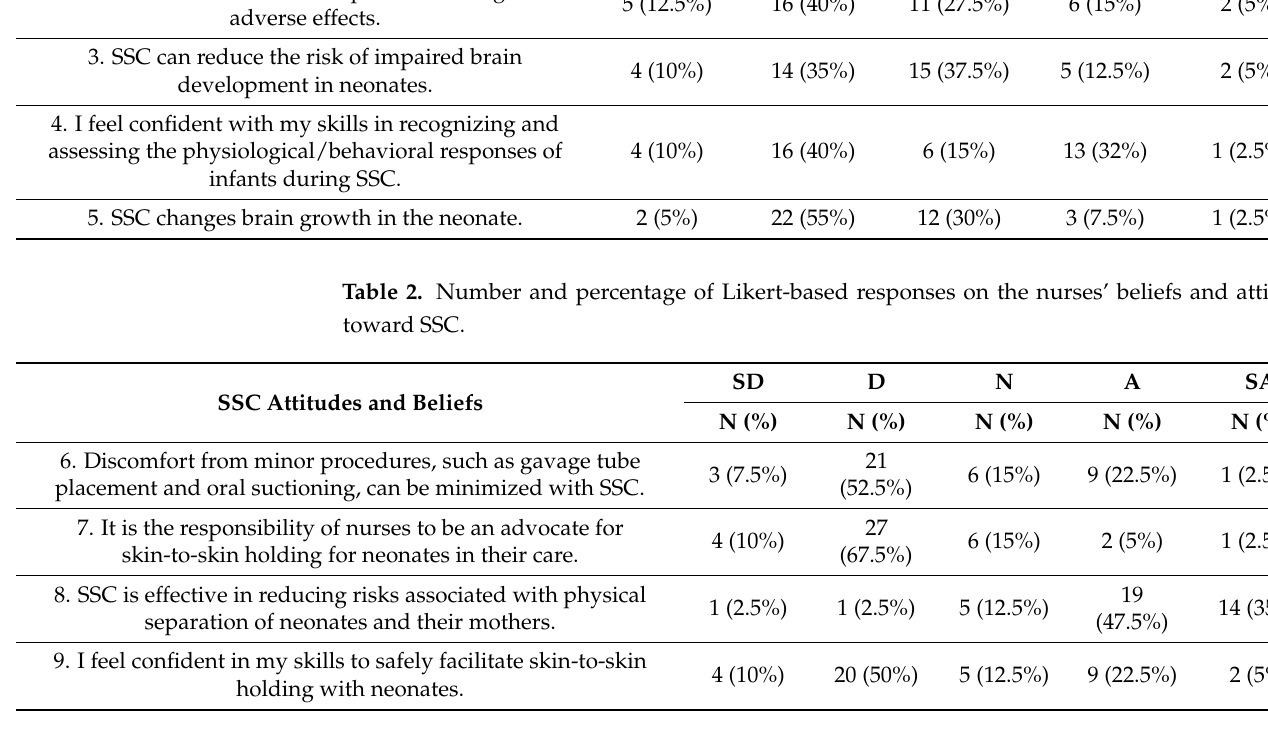
Table 3. Number and percentage of Likert-based responses on the nurse’s SSC